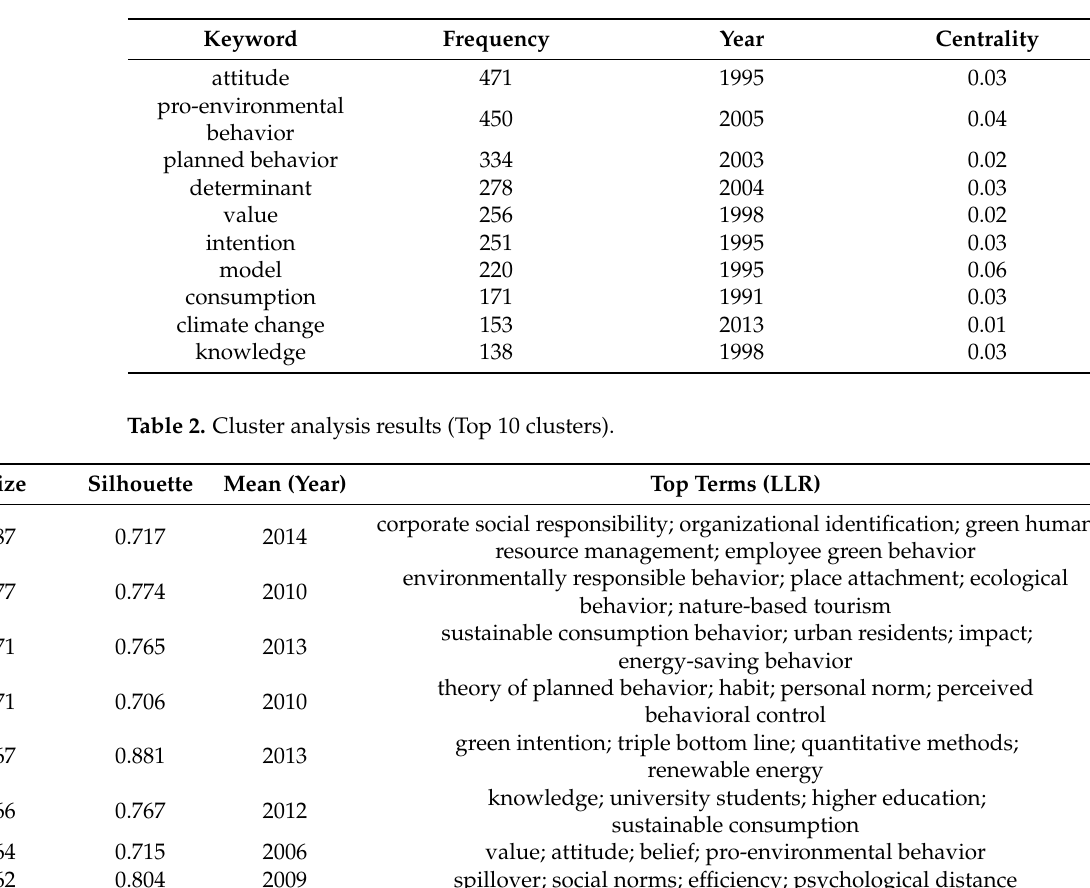
Table 1. Co-occurrence analysis results (Top 10 keywords).